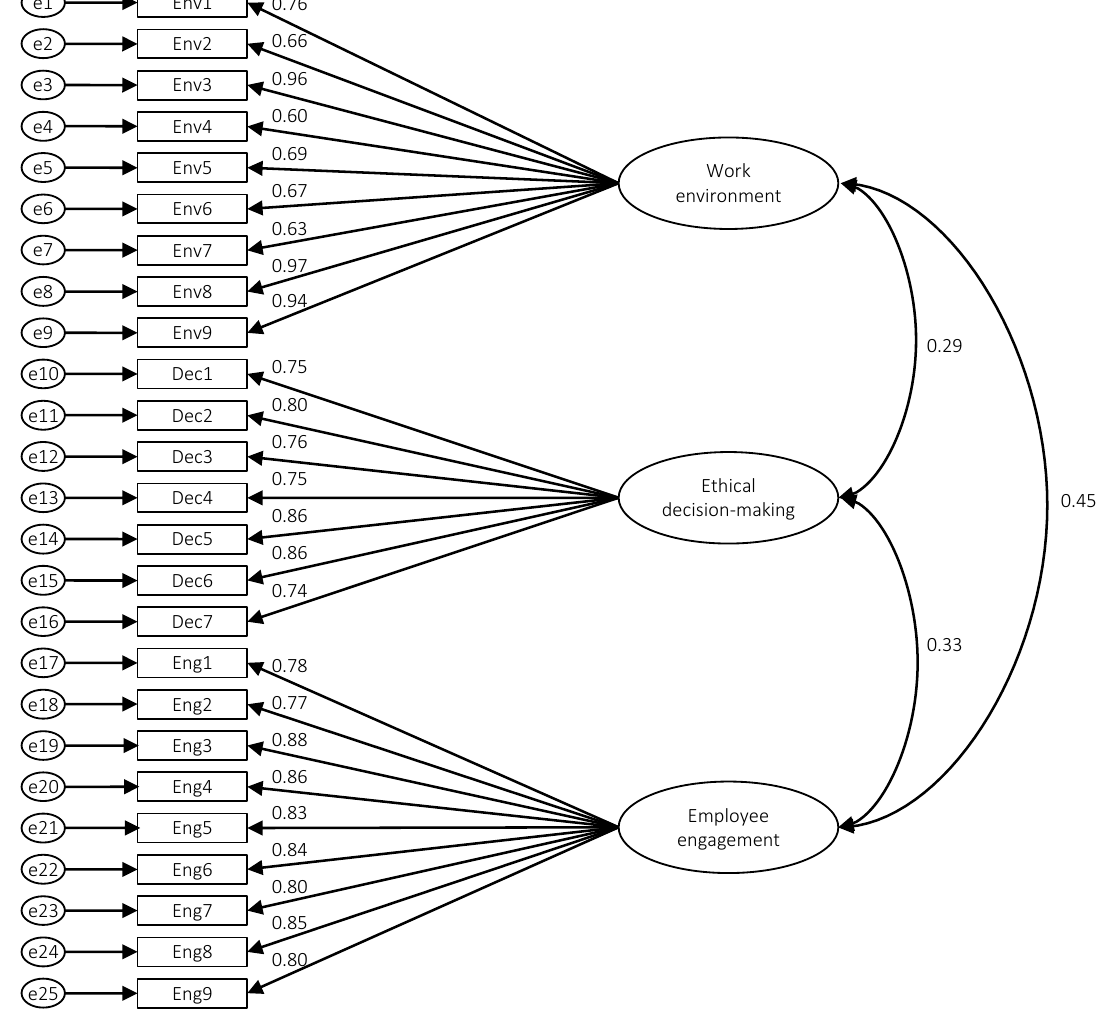
Figure 2. Confirmatory factor analysis/measurement